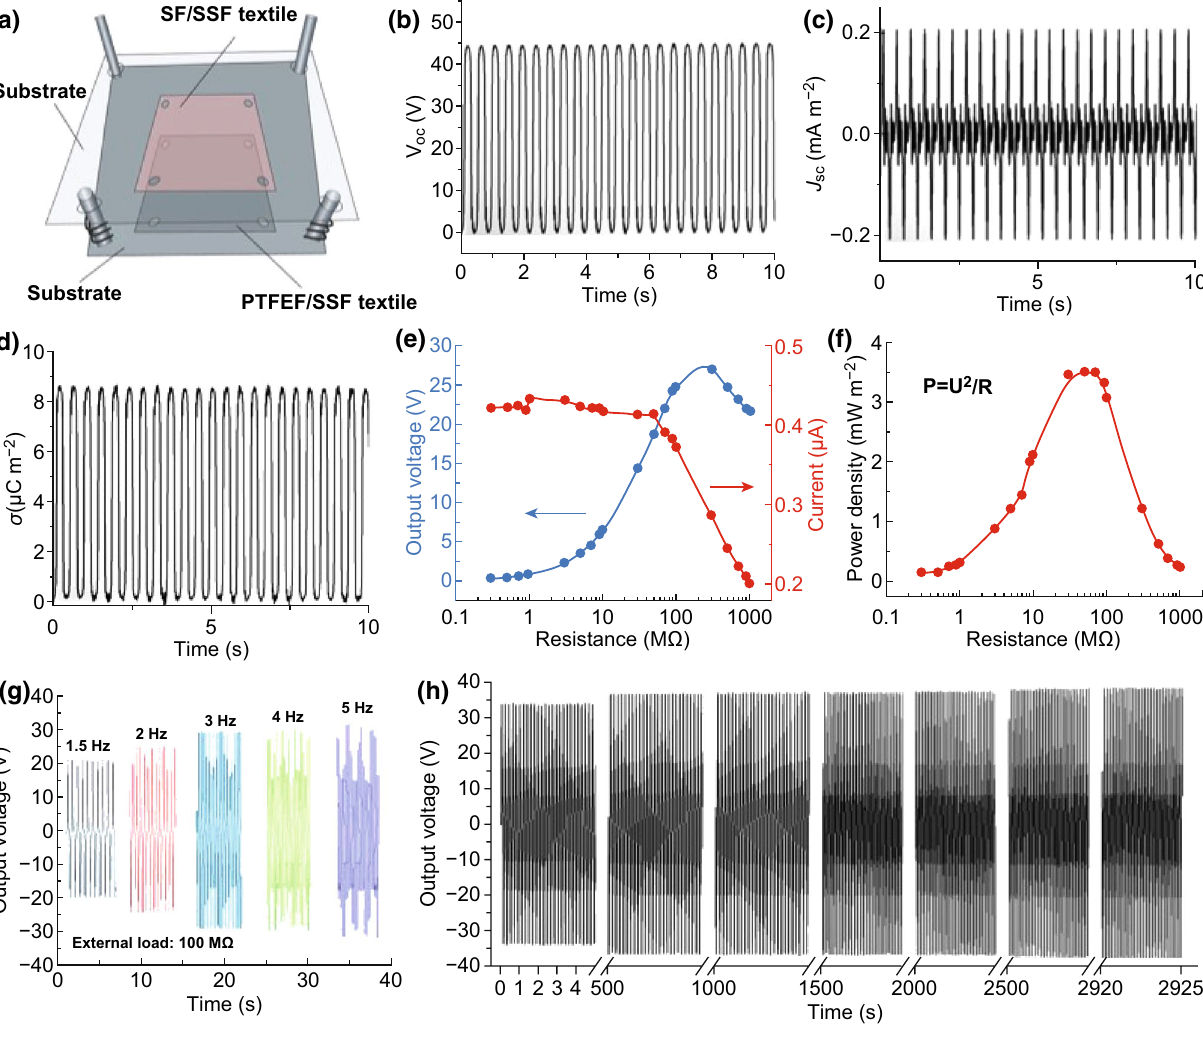
Fig. 7 EHT and its electrical output characterization: a Schematic illustration of self-powered EHTs. b – d The open-circuit voltage ( V oc ), short- circuit current density ( J sc ), and transferred charge density ( σ ) of EHT under an operation frequency of 2 Hz, respectively. e Dependence of cur- rent and voltage output of EHTs on the external loading resistance. f Dependence of power densities of EHT on the external load resistance. g Measured output voltage of EHTs on the external loading of 100 MΩ at different work frequencies. h Stability and reliability of SF/PTFEF EHT measurements, where the voltage was recorded for 14,000 cycles on the external loading of 100 MΩ and work frequency of 5